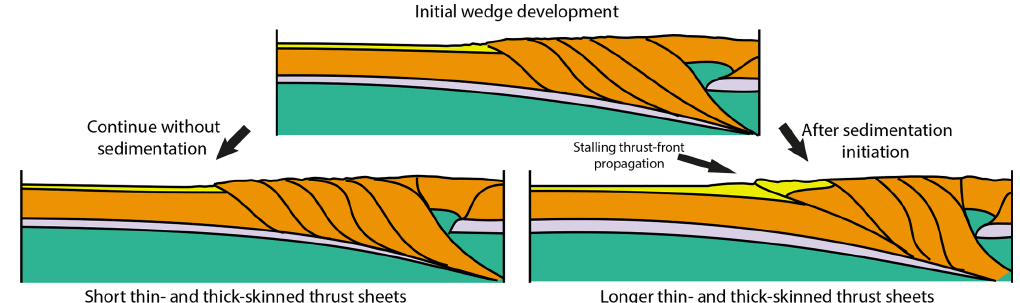
Figure 9. Conceptual figure showing the difference between the evolution of a mountain belt with and without intensive late-stage sedimen- tation. The cartoons are generalizations of our model results, depicting them after the same amount of